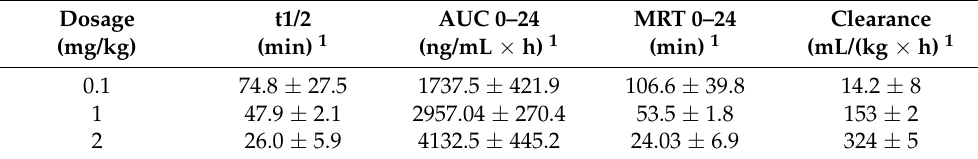
Table 1. Pharmacokinetic properties of